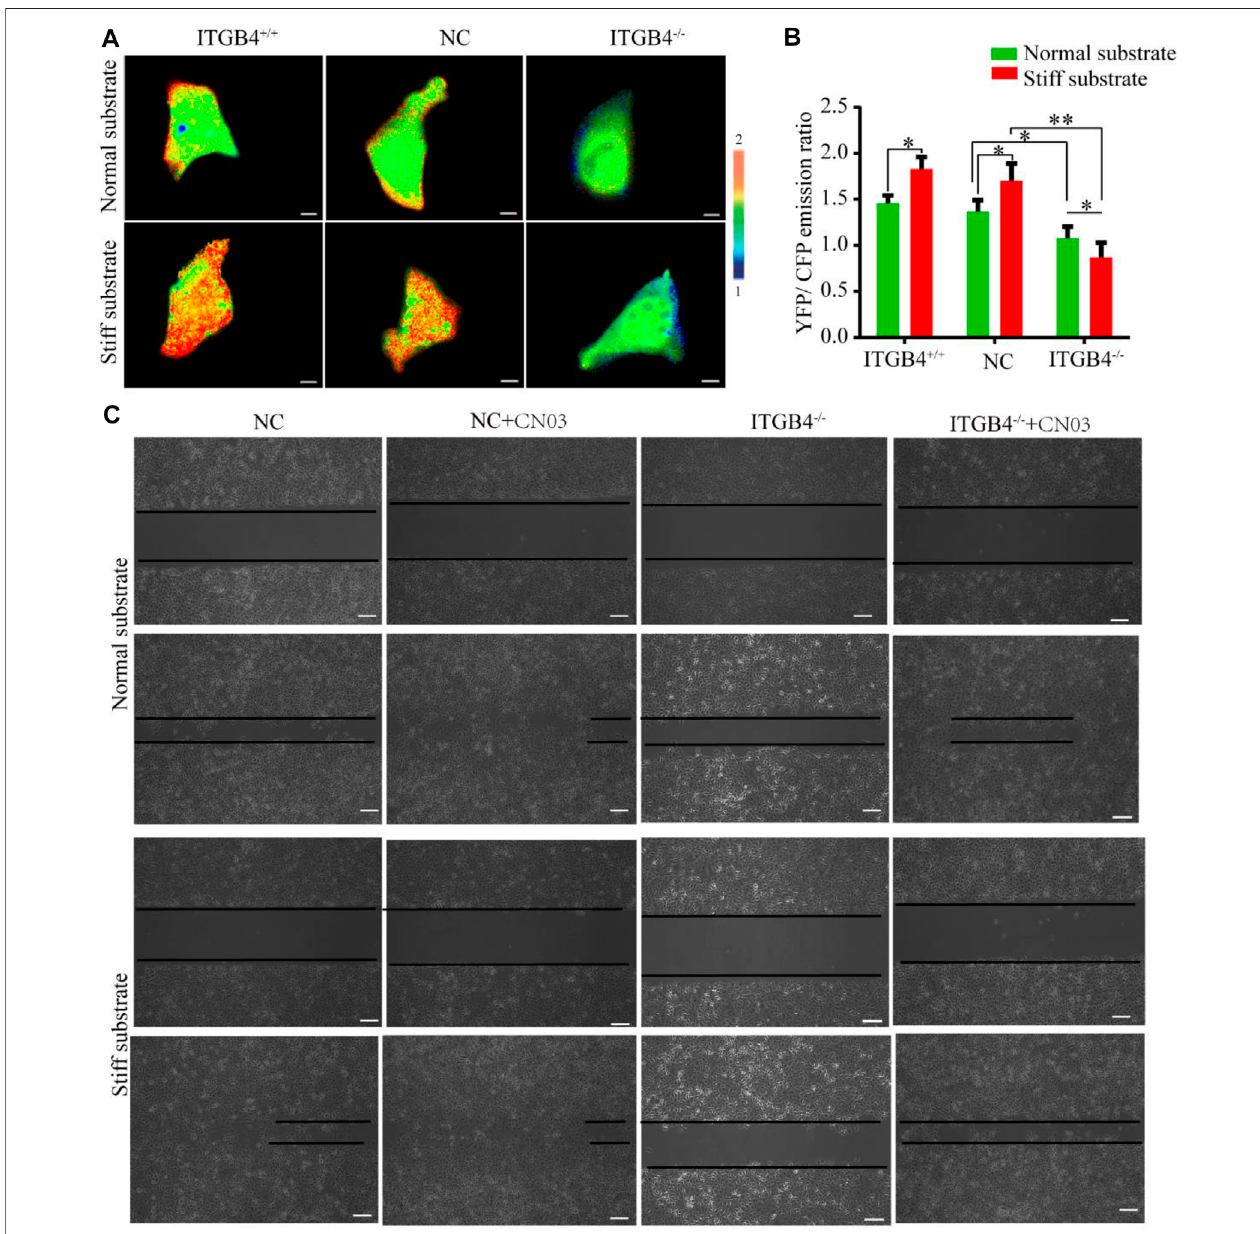
FIGURE9| RhoAactivityandmigrationofcells. (A,B) ImagesoftheemissionratiosofYFP/CFP-basedRhoAbiosensorincellsonnormalandstiffsubstrate.Cells are shown on the left, the right panels show the emission ratios of the YFP/CFP-based RhoA biosensors (C) Representative images of wound-healing response for NC and ITGB4. − / − cellsonnormaland stiffsubstratebeforeandafter CN03treatment. (D) TrackmigrationofNCandITGB4 − / − cellsonthenormalandstiffsubstrate before and afterCN03treatment,monitoredfor24 h( n =40). Trackswererecordedinthe x / y directions. (E) Quantitation oftherateofrepairat24 hpost-injury(relativeto 0 h, n = 40). (F) Box-and-whisker plot of cell migration velocity ( n = 40). ( n = 3 independent experiments, * p < 0.05; ** p < 0.01). Data are presented as mean ± SD.